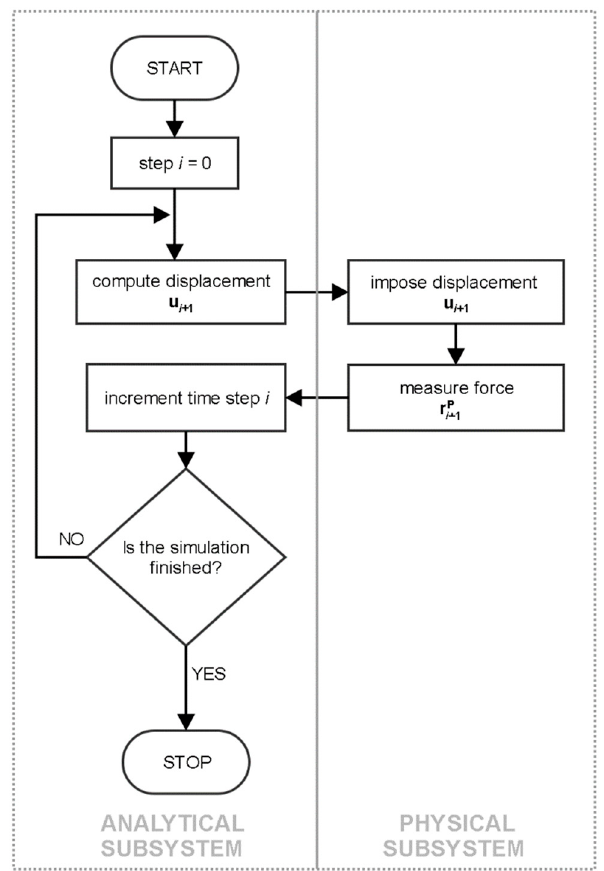
Figure 1. Hybrid simulation algorithm.